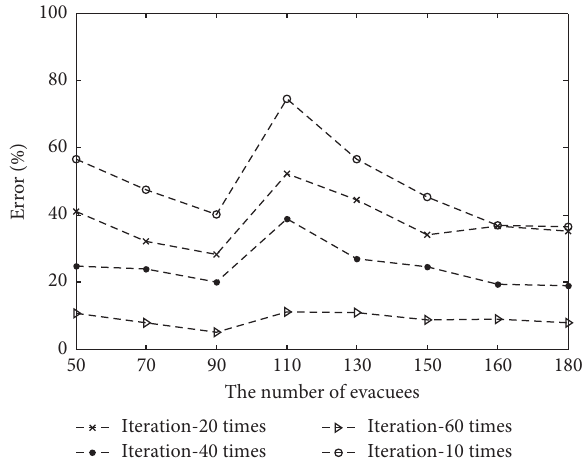
Figure 5: The change between the evacuation time error and the number of evacuees under different iterations. Table 1: The trend of the average error in different iterations. The number of iterations